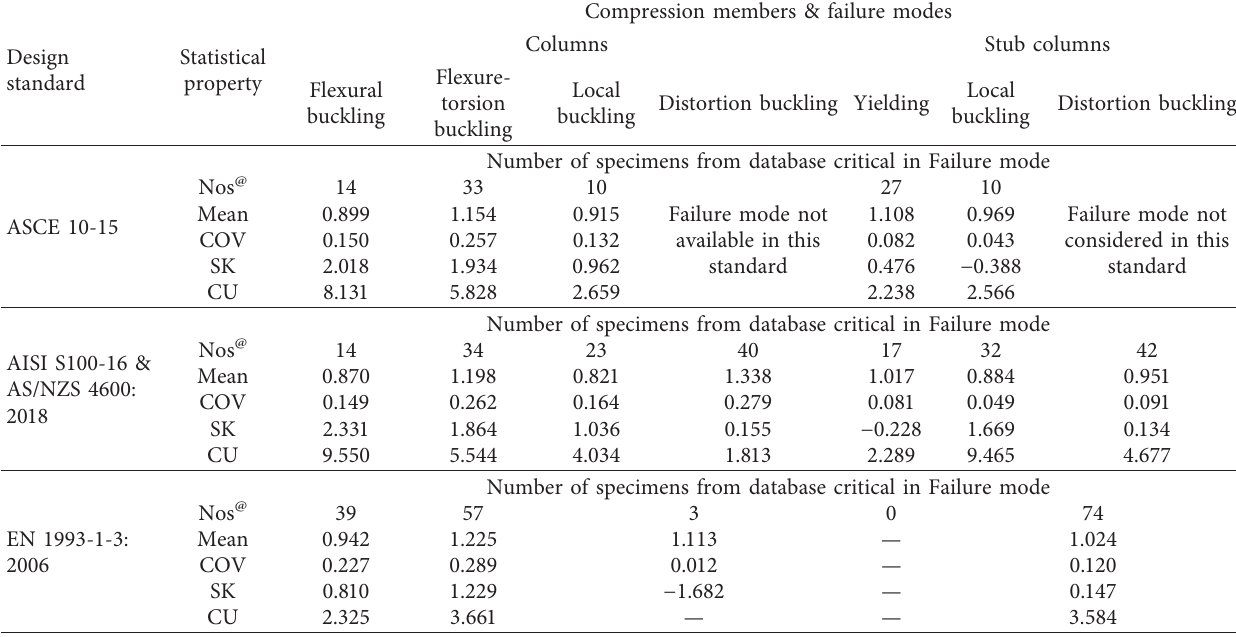
Table 6: Statistical properties of modelling error of test database compression